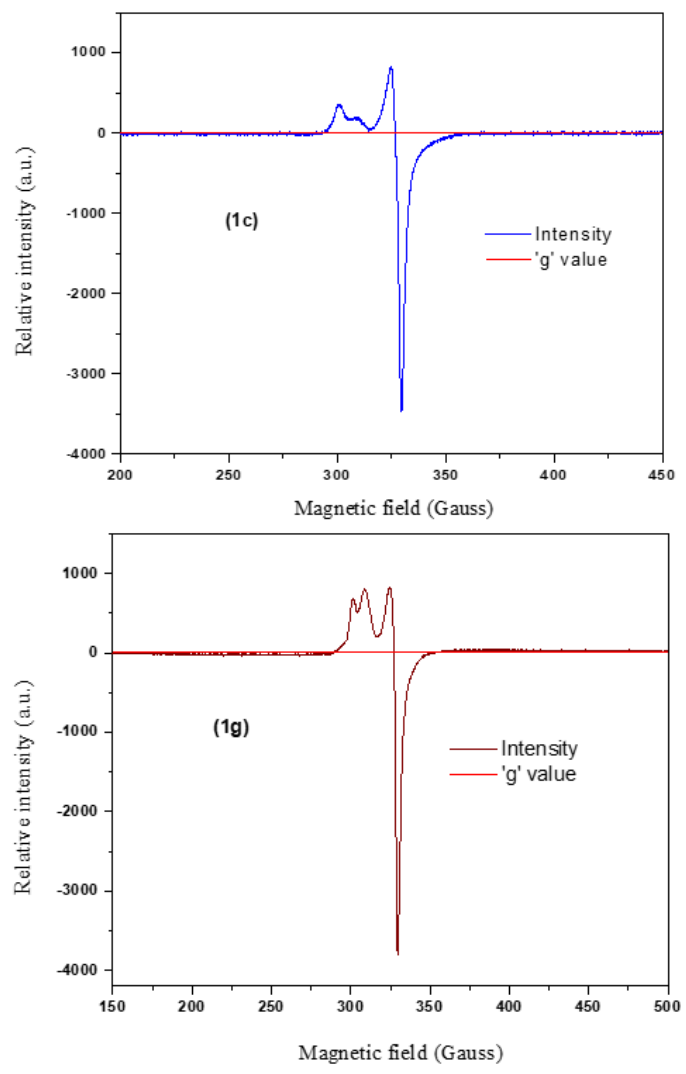
Figure 3. X−band EPR spectrum of complex [Cu(L)(phen)] 1c and [Cu(L)(bpy)] 1g at room tempera- Figure 3. X − band EPR spectrum of complex [Cu(L)(phen)] 1c and [Cu(L)(bpy)] 1g at room ture.